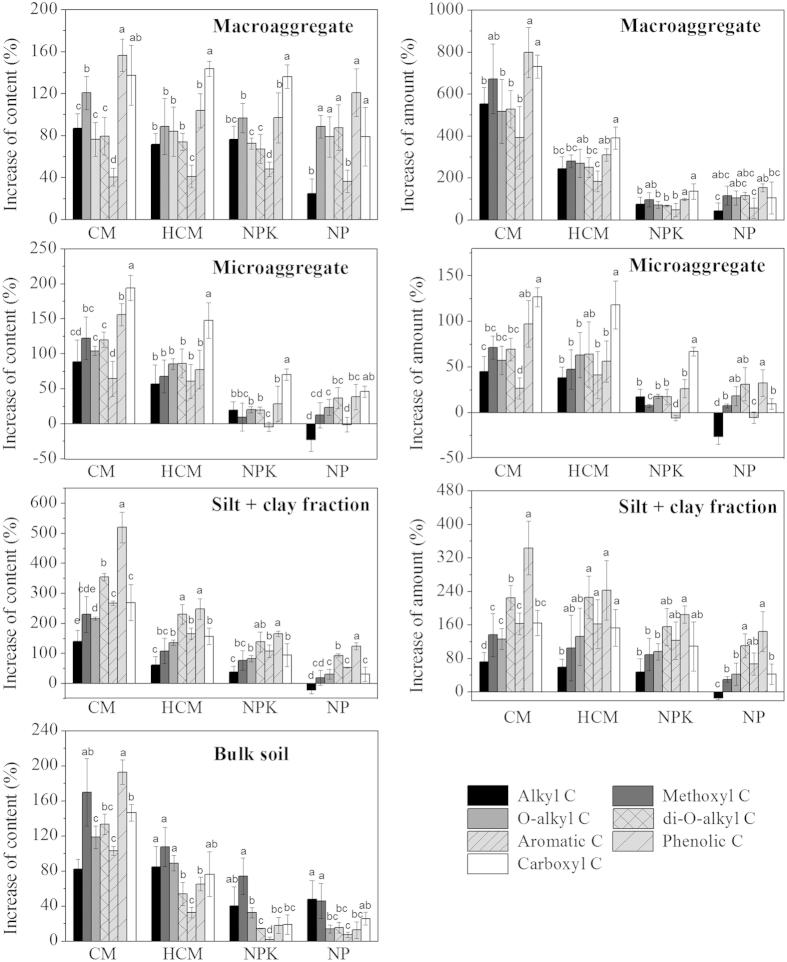
Increase in organic C functional group content or amount in bulk soils and aggregates, as affected by long-term application of compost and fertilizers.Different lowercase letters indicate significant differences between C functional groups for the same treatment and aggregate (Tukey’s test, P < 0.05, n = 4).